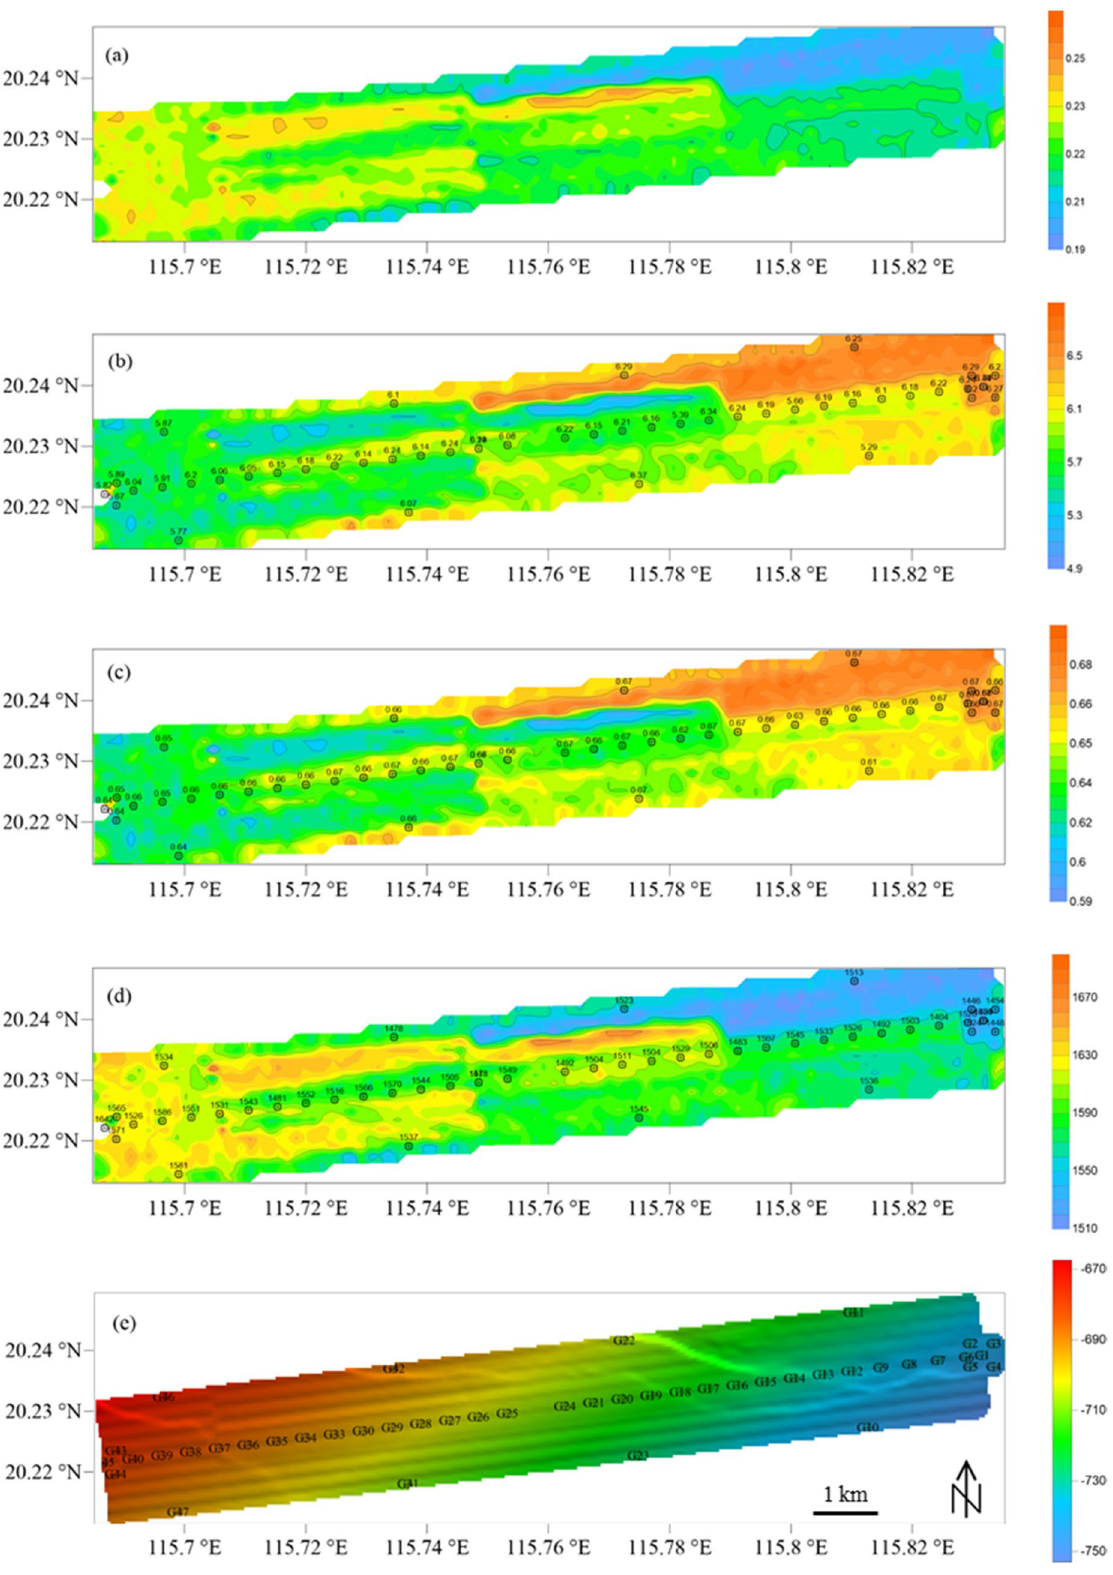
Figure 6. Comparison of the inversion results and sample test results of the physical properties of seafloor surface sediments: ( a ) seafloor reflection coefficient; ( b ) mean grain size (unit: ϕ ); ( c ) porosity; ( d ) density (unit: g/m 3 ); ( e ) seafloor topography and sampling